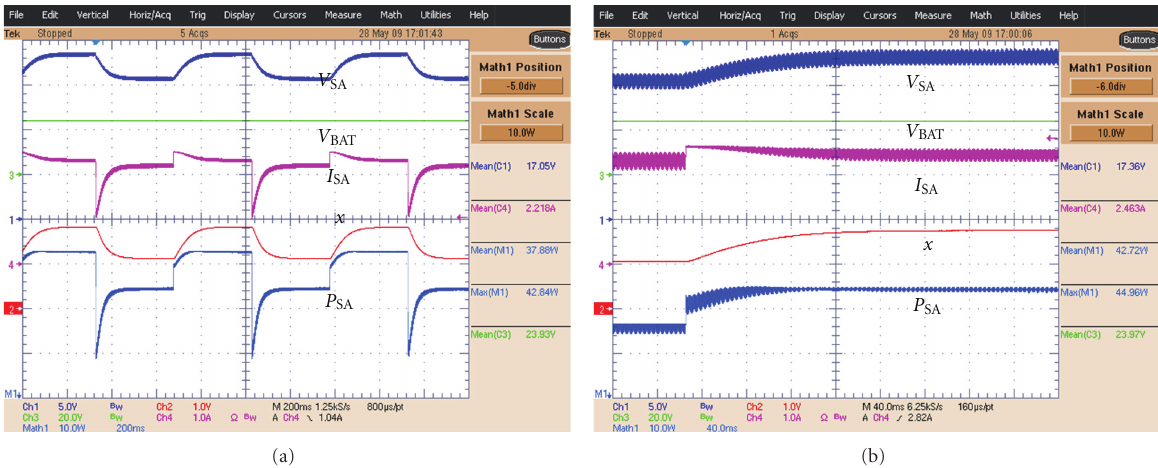
Figure 7: (a) Transient waveforms for voltage-pulsed signal in series with the PV panel. (b) Detail of transient for voltage pulse added to panel voltage.